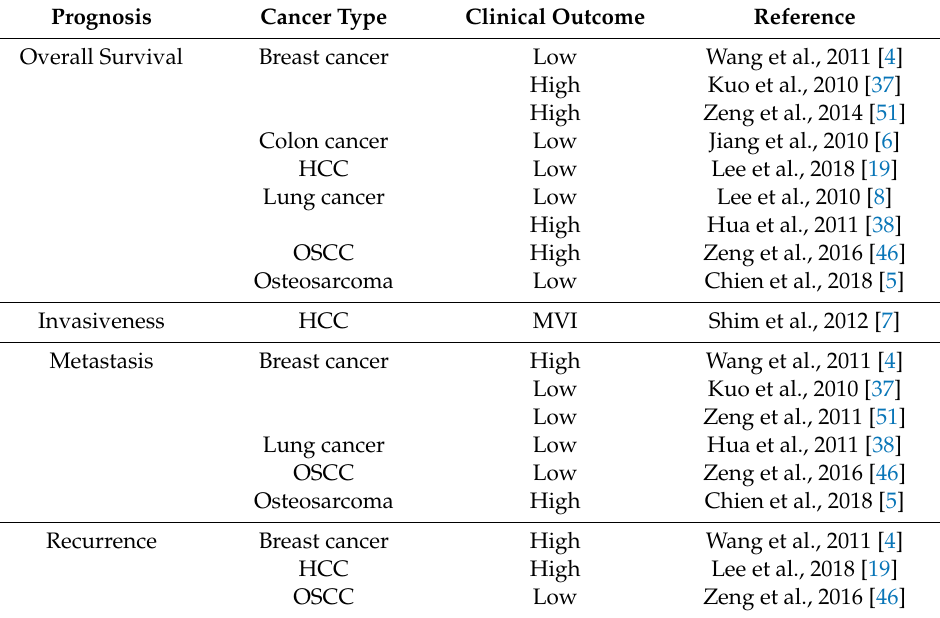
Table 1. Clinical outcome in cancer tissues overexpressing